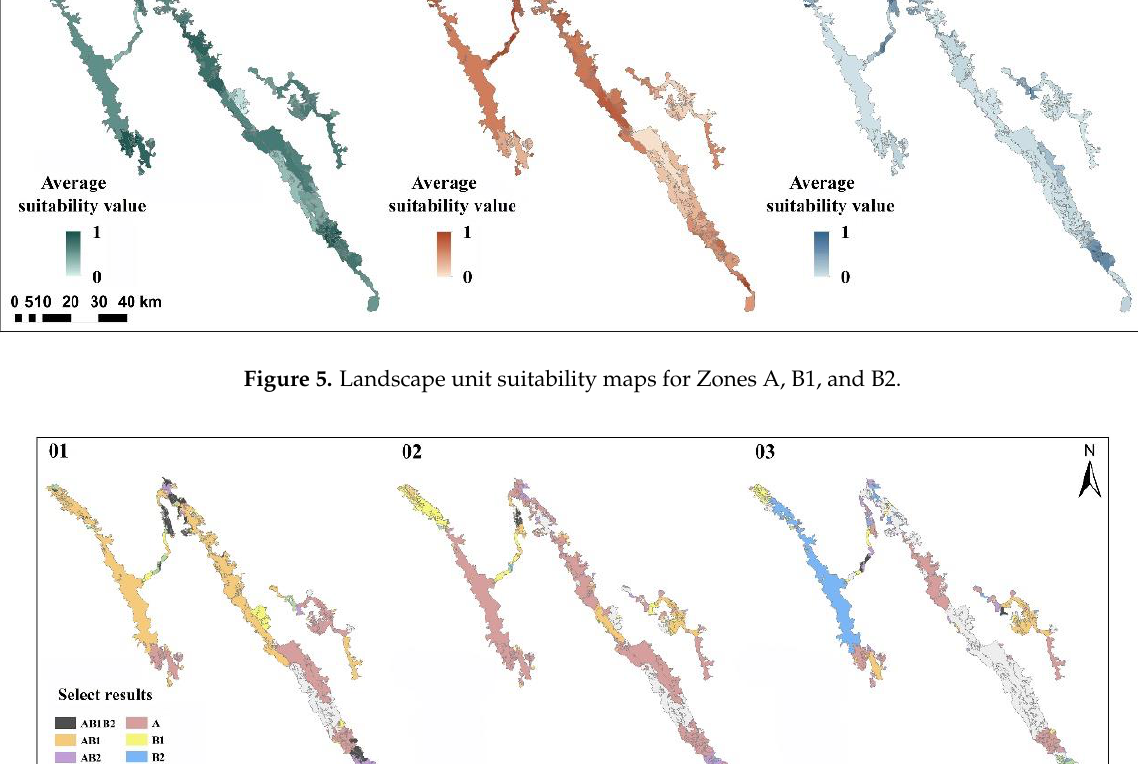
Figure 6. Landscape unit assignment conflict analysis (01, average; 02, average among best 50% cells; 03, average among best 30% cells).